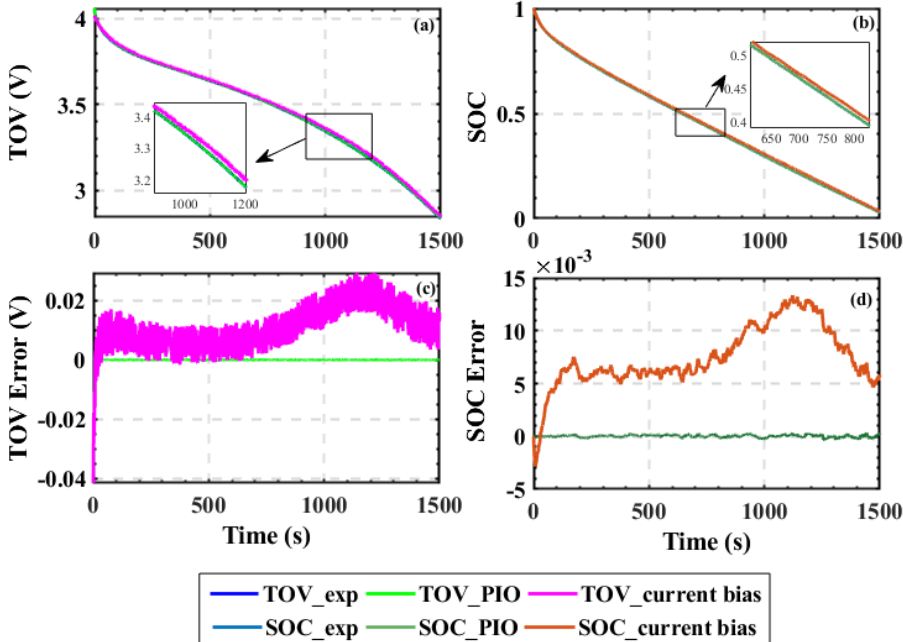
Figure 4. Estimation results of the model TOV and SOC considering sensor bias at 2 C condition. ( a ) Results of TOV, ( b ) Results of SOC, ( c ) Errors of TOV, ( d ) Errors of SOC.